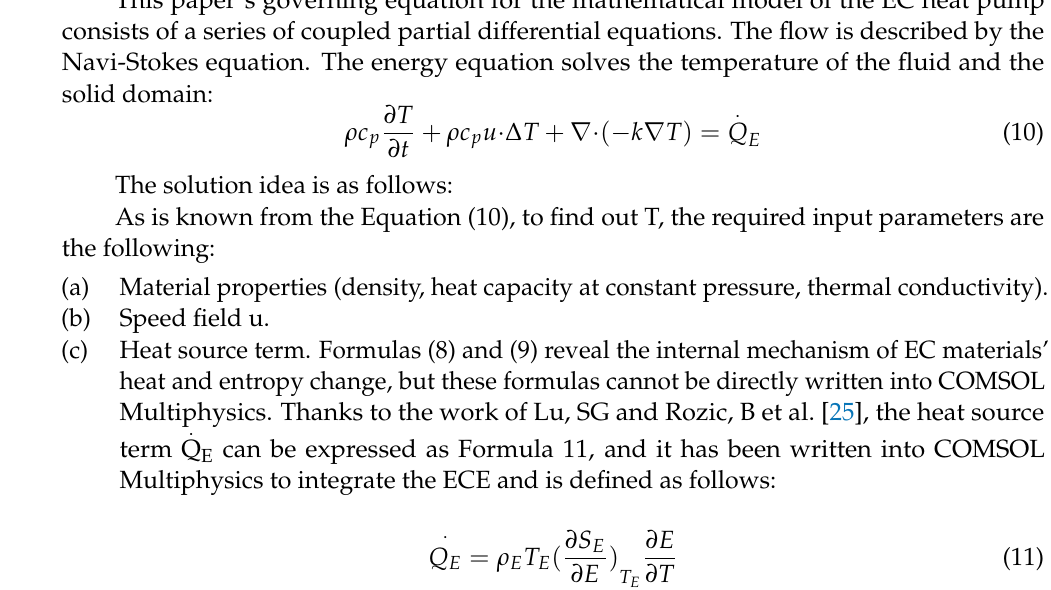
Figure 5. Grid details and boundary conditions.